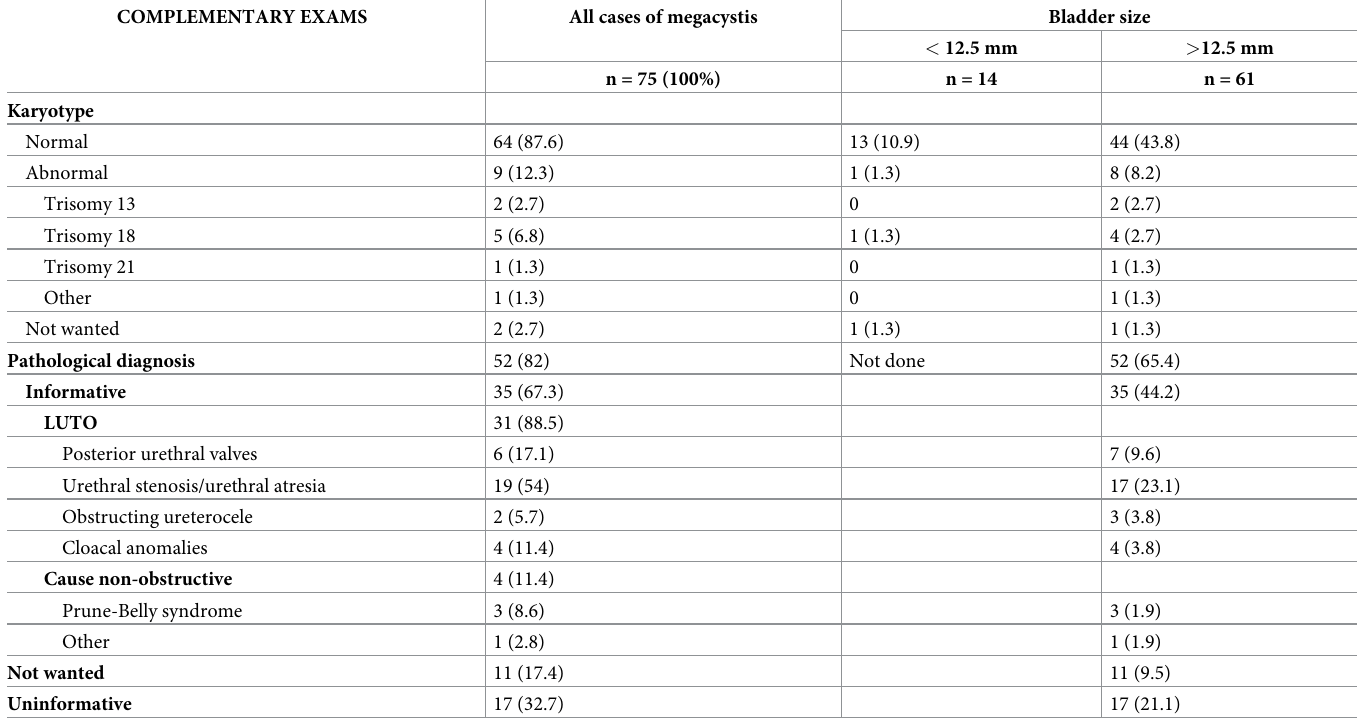
Table 3. Antenatal and postnatal characteristics of fetuses according to neonatal outcome.